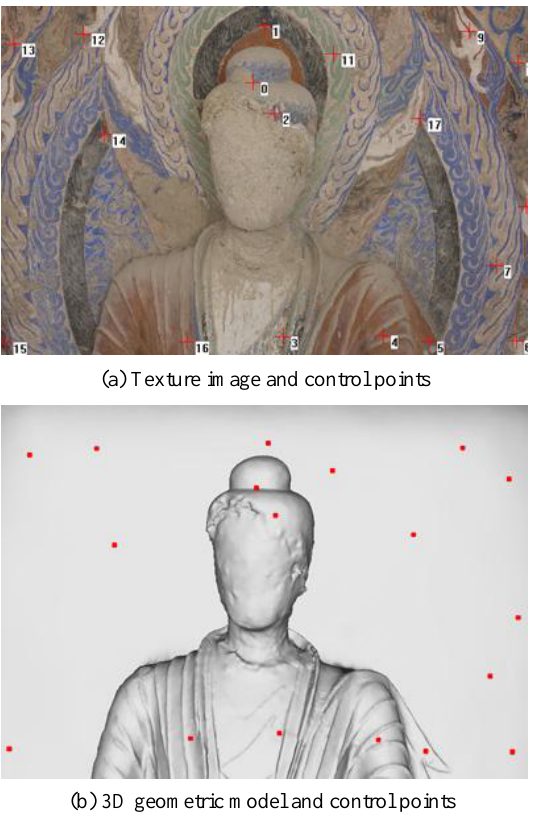
Figure 3. Data of experiment 2